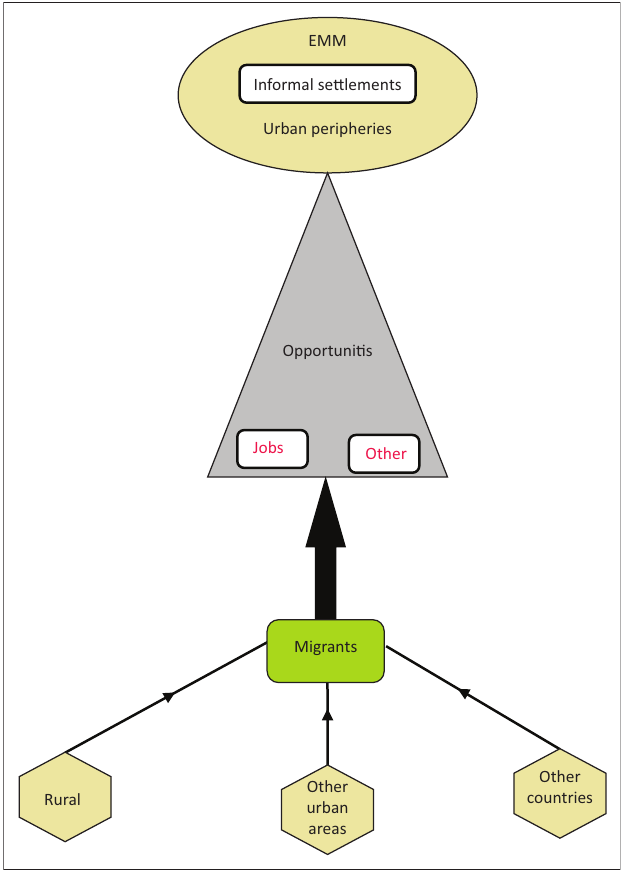
FIGURE 2: Migration into Ekurhuleni Metropolitan